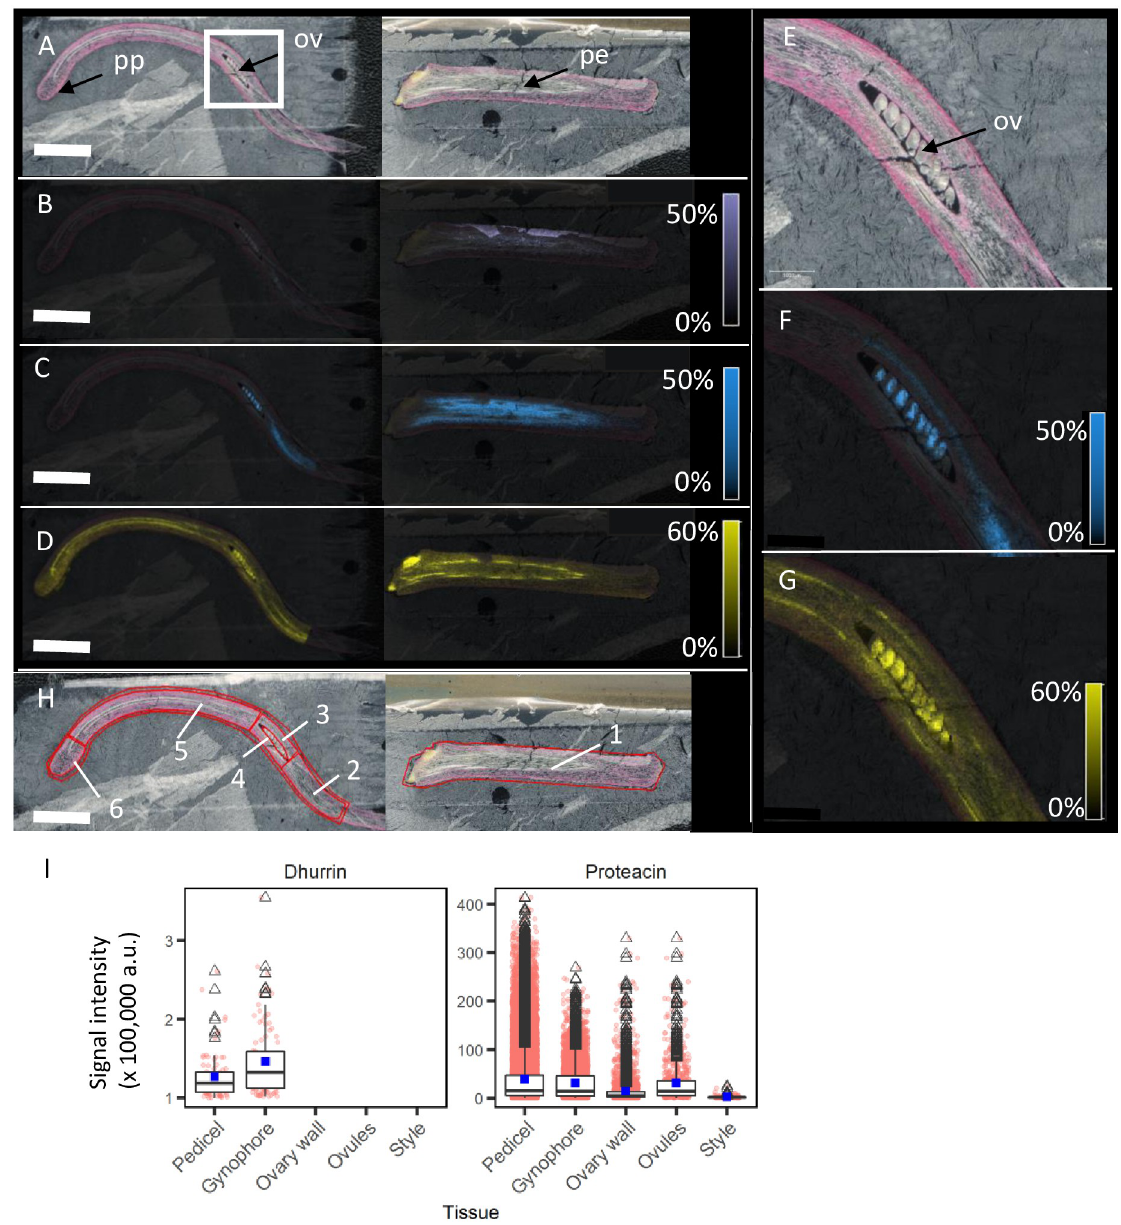
Fig 7. MALDI-MS images of longitudinal sections of a Telopea speciosissima floret without perianth showing the pistil (left) and pedicel (right). (A) Optical image of floret longitudinal-section (35 μ m thick), where pp is pollen presenter, ov–ovules, pe–pedicel. (B) proteacin [M + Na] + ( m/z 496.1421, Δ m 0.8 mDa), (C) proteacin [M + K] + ( m/z 512.1164, Δ m 0.2 mDa) and (D) hexose [M + K] + ( m/z 381.0792, Δ m 0.5 mDa). (E) Inset of T . speciosissima ovary (white square from figure A), (F) proteacin [M + K] + ( m/z 512.1164, Δ m 0.2 mDa), (G) hexose [M + K] + ( m/z 381.0792, Δ m 0.5 mDa). All MALDI-MS images were obtained using 50 × 50 μ m array. White scale bars indicate 5 mm. Coloured intensity scales represent 0–50% RMS normalised signal intensity (0–60% for hexose). (H) Regions of Interest (ROIs) selected for cyanogenic glycoside signal intensities comparison analysis–(1) pedicel, (2) gynophore, (3) ovary wall, (4) ovules, (5) style, (6) pollen presenter. (I) Signal intensities of dhurrin ([M + K] + ( m/z 350.0635)), and proteacin ([M + K] + ( m/z 512.1164) and [M + Na] + ( m/z 496.1421) combined) for respective ROIs, the box plot represents the entire signal intensity delimited by the 25 th and 75 th percentiles, with error bars denoting the 10 th and 90 th percentiles. Values outside those ranges are represented by open triangles, the mean (dark blue square) and median (solid line). Pink dots represent signal intensity in individual pixel. Dhurrin to proteacin ratios in tissues are provided in S4 Table.